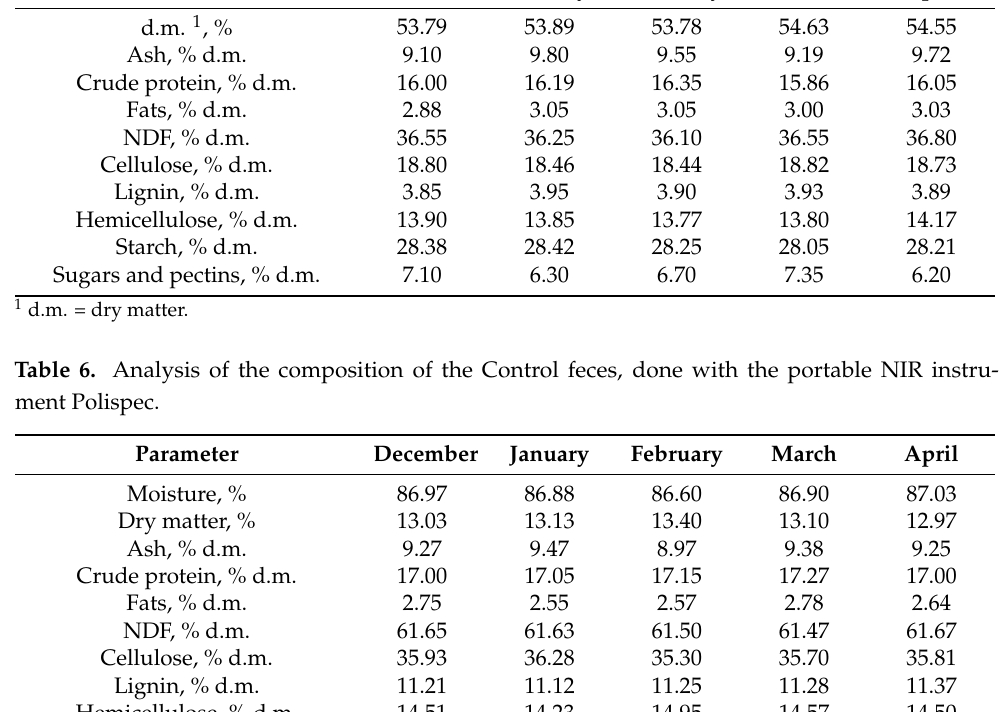
Table 5. Analysis of the composition of the Treatment diet, done with the portable NIR instru- ment Polispec. Parameter